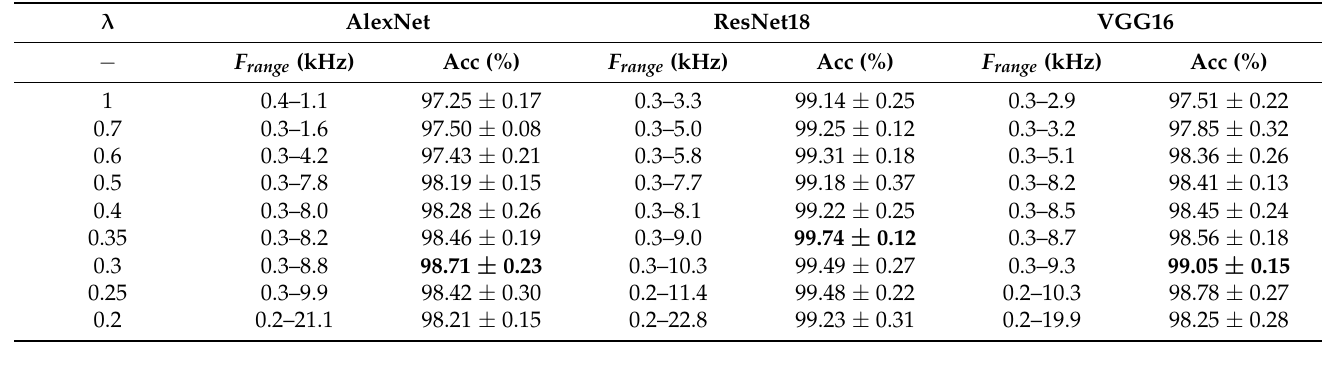
Table 3. Results of different λ on JNU.